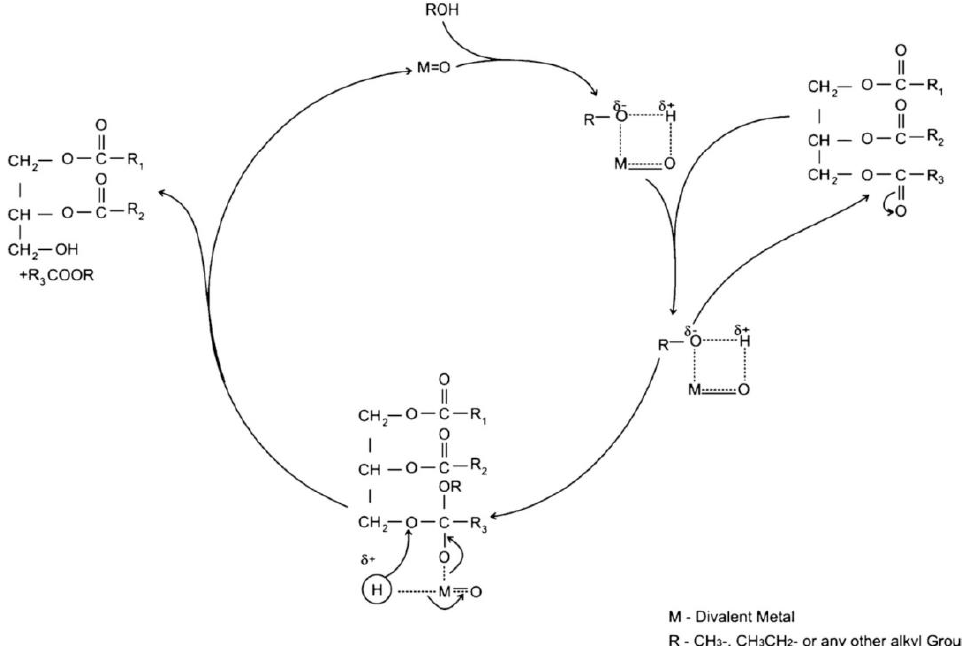
Figure 7. Heterogeneous base catalysts for biodiesel synthesis. Data adapted from [120], published by Elsevier, 2011.